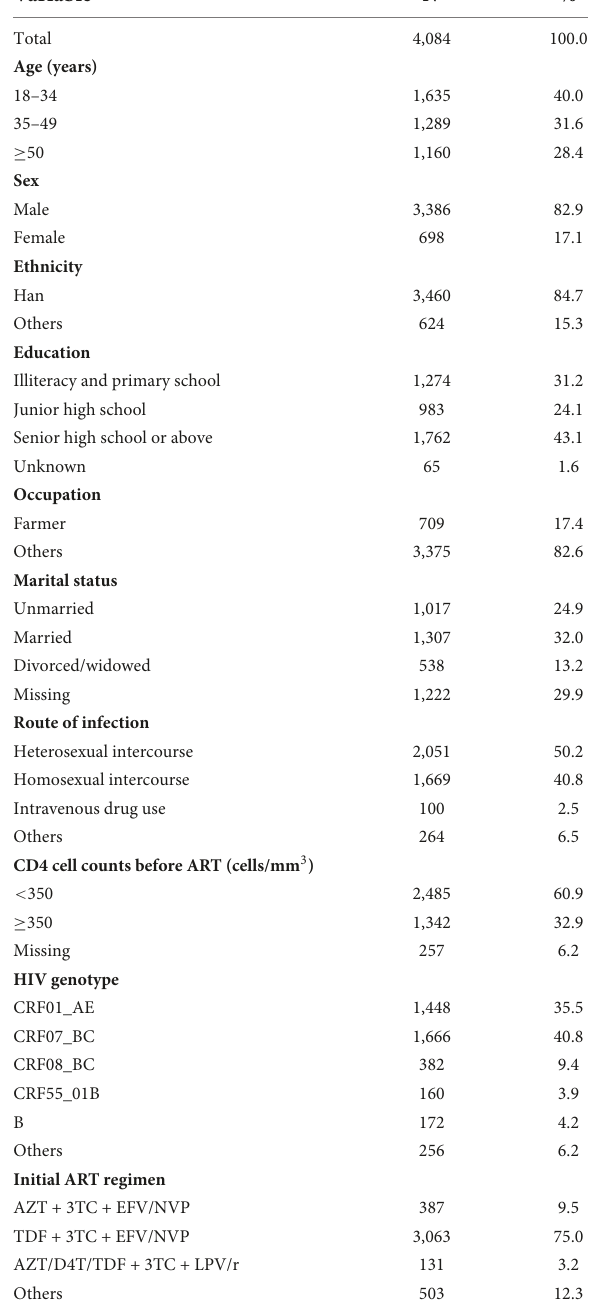
TABLE 1 Baseline characteristics of HIV-positive individuals in China,